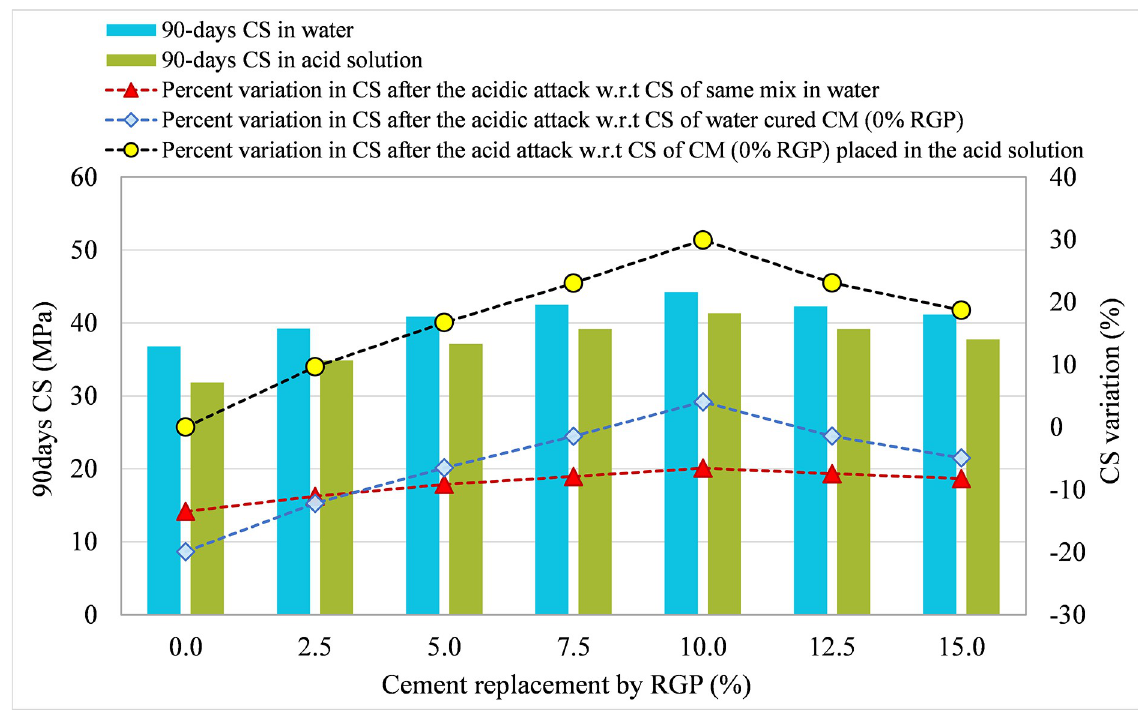
Fig 10. CS variation in samples placed in plain water and the acid solution for SF-15 mix incorporating RGP as a cement